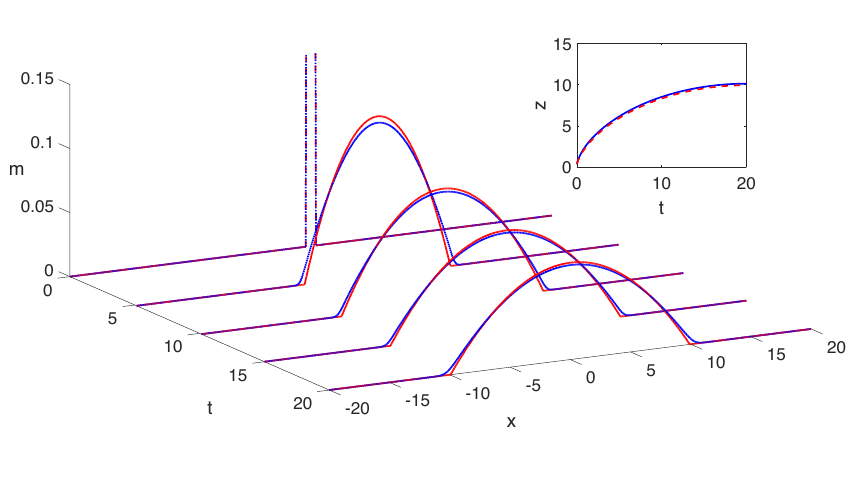
Figure 4: Computational solution of the Gross-Pitaevskii equation (dot) and parabolic ansatz (dashed). The inset shows the time evolution of z numerically (full) and analytically (dashed). In this case, we have chosen g = − 2, σ = 0.45 and µ = 1, meaning ν ≈ 0.02. The actual (numerical) game takes place from t = 0, when it starts as an inverted parabola of extension 0.4, to t = T = 20 when the terminal cost is flat. The effective game starts at time t ≈ − 0.07 as a Dirac delta function and its effective duration is ˜ T ≈ 20.07. The only difference between the numerical results and the parabolic ansatz comes from the fact that σ is non-zero in the